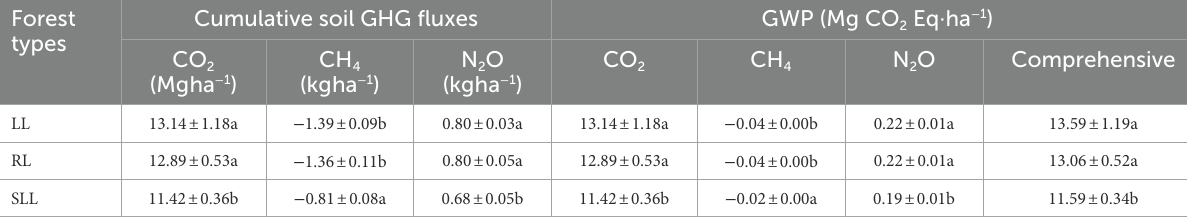
Values are the mean ± SD. Different lowercase letters behind the number indicate statistically significant difference among different types of larch forest. LL, Ledum palustre - Larix gmelinii forest; RL, Rhododendron dauricum - Larix gmelinii forest; and SLL, Sphagnum-Bryum-Ledum palustre-Larix gmelinii